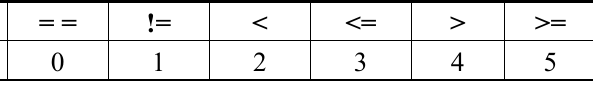
Table 4. Relational operators.